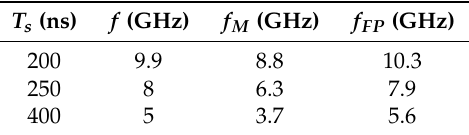
Table 5. Measured frequencies f M and f FP obtained using Michelson and Fabry–Perot interferometers with OPD ∆ L = 0.16 m and T s of 200, 250, and 400